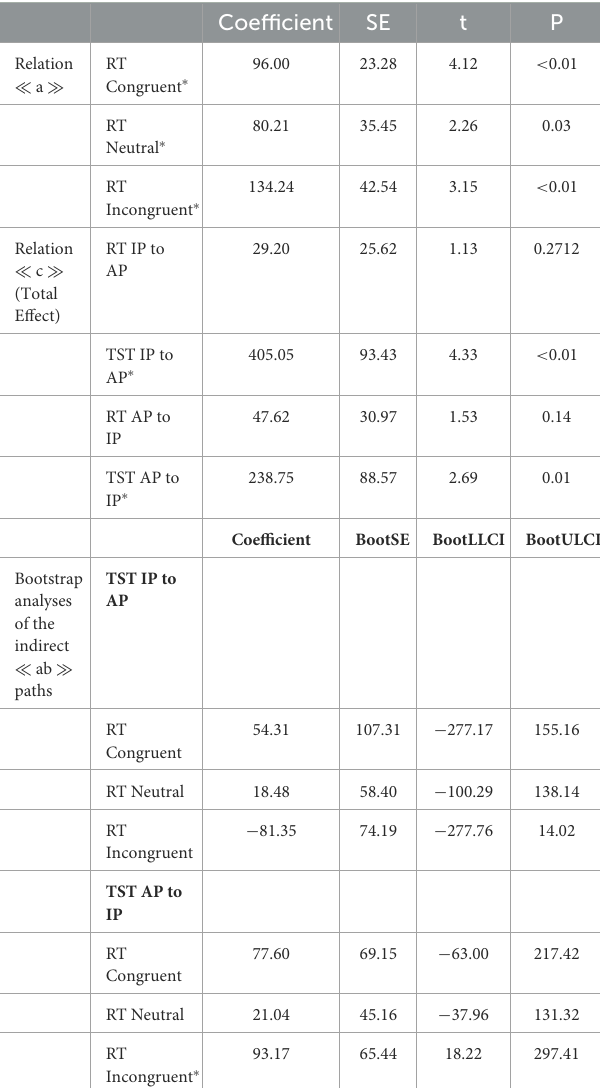
TABLE 2 Training-related enhancement of intentional switching variables (i.e., RT and TST) mediation through improvements in inhibition capacities as measured by the CSWT (unstandardized reported effect).